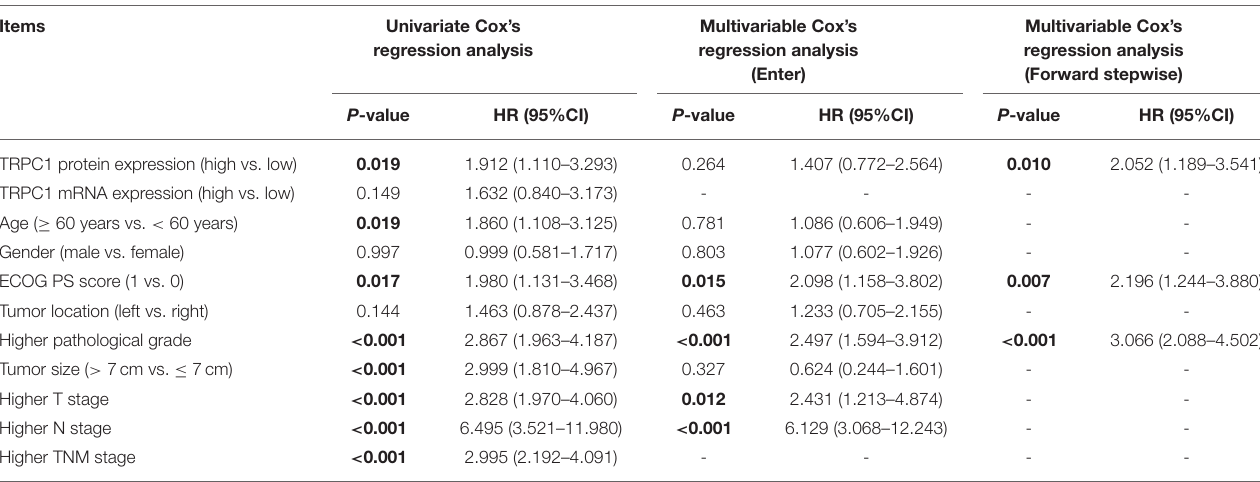
TABLE 2 | Factors affecting overall survival (OS) by Cox’s proportional hazards regression